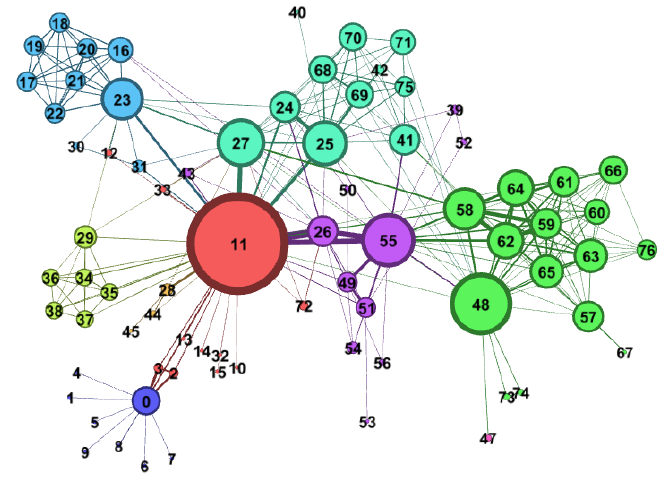
Figure 7. The network graph of C3DPS Network ( _ S Net